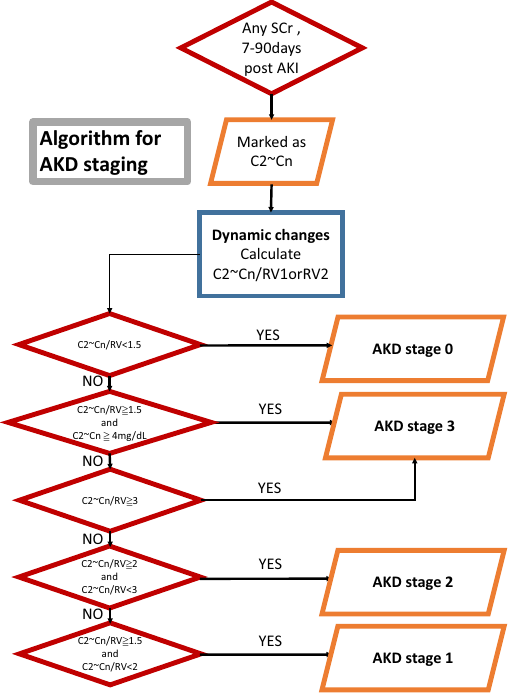
Figure 1. Algorithm for the staging of acute kidney disease. Algorithm for the staging of acute kidney disease (AKD), based on the 16th Acute Disease Quality Initiative (ADQI) consensus, which is congruent with AKI staging. SCr serum creatinine, RV reference value. Patients with AKD stage 0 by this algorithm were considered as reference group in the following statistical analysis. Conversion factors for serum creatinine in mg/dL to μmol/L, ×